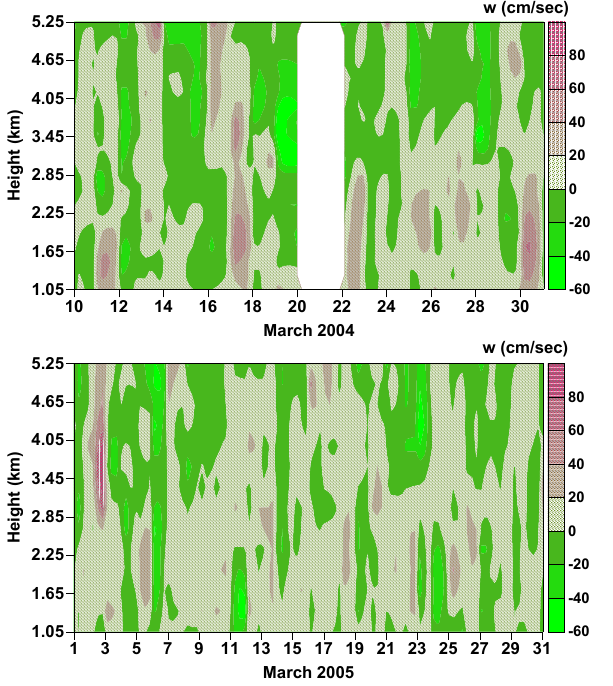
Figure 6 Fig. 6. Time-height cross sections of Wind Profiler-derived vertical velocities in March 2004 (top panel) and in March 2005 (bottom panel).